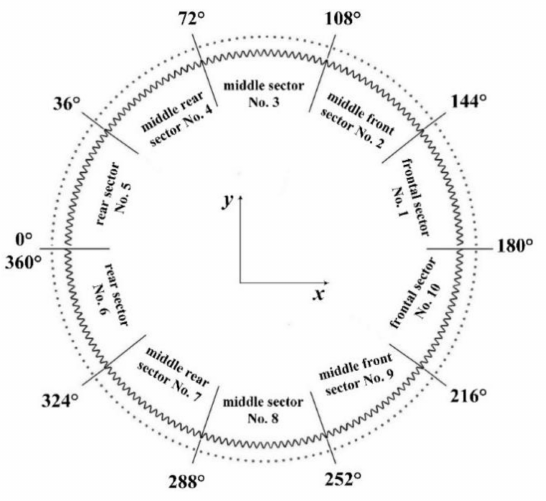
Figure 2. Schematic of air-cooled sector